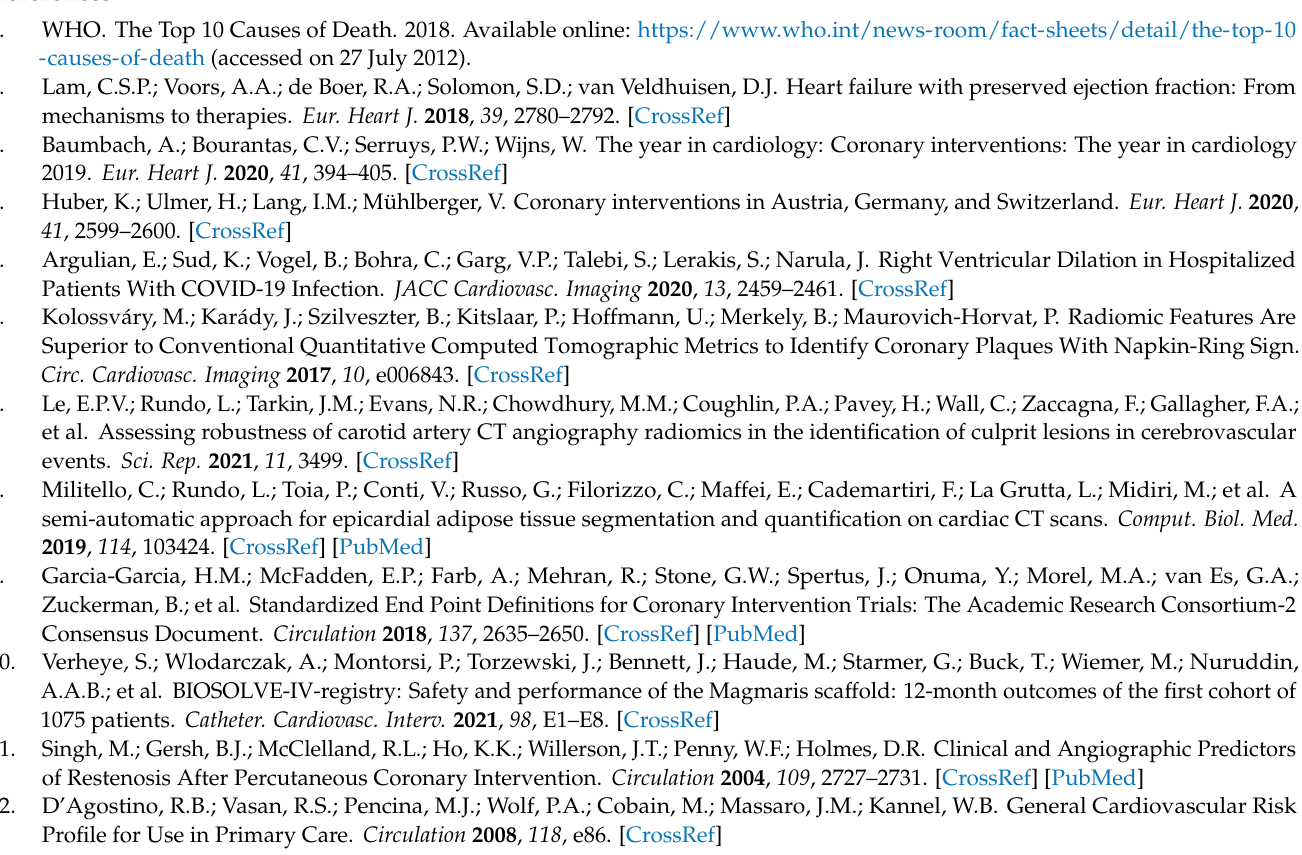
disease in literature, Table S2: Cohort features (part 1): patient characteristics and statistics, Table S3: Cohort features (part 2): procedural information and statistics, Table S4: Cohort features (part 3): lesion characteristics and statistics, Table S5: Cohort features (part 4): medication and statistics, Table S6: Cohort features (part 5): discharge information and statistics, Table S7: Explanation of ordinal features, Table S8: Model structure for final TLF models, Table S9: Fixed and tuned hyper- parameters for TLF